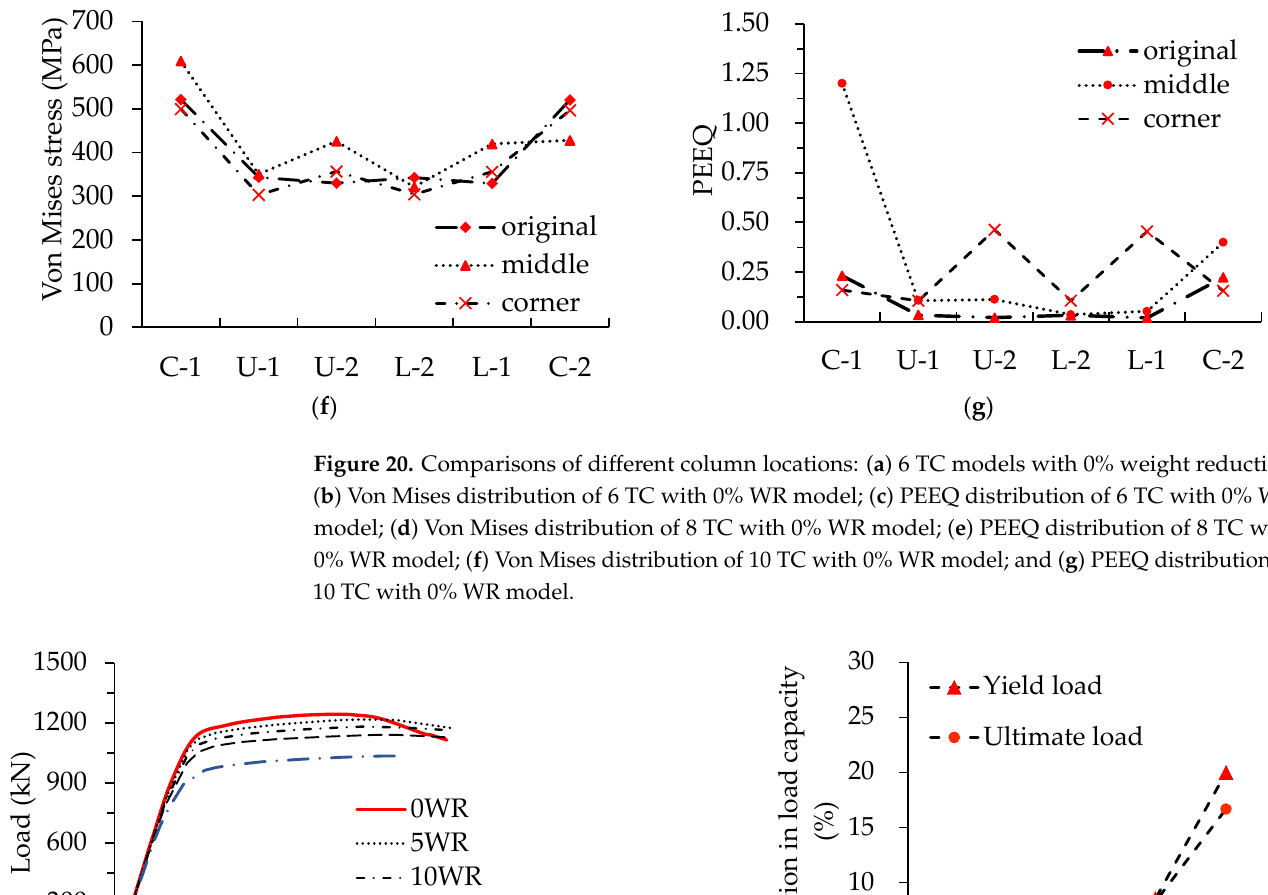
in the middle of the corner fitting are much higher than other locations for 10 TC models.